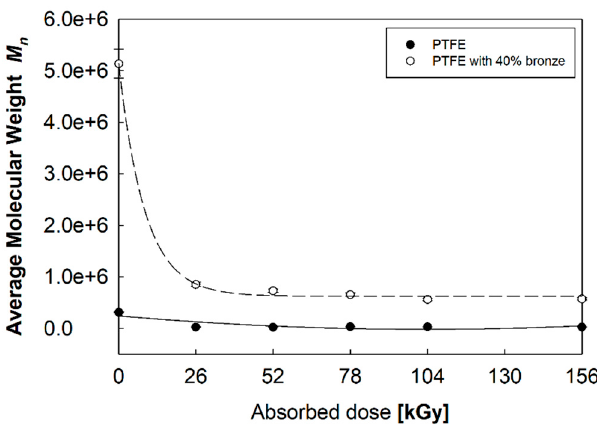
Figure 5. Variation of the average molecular weight M n of PTFE and PTFE with a 40% addition of bronze in their initial states and after electron beam irradiation.